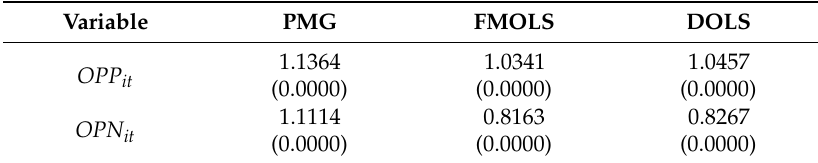
Table 6. Long-run panel